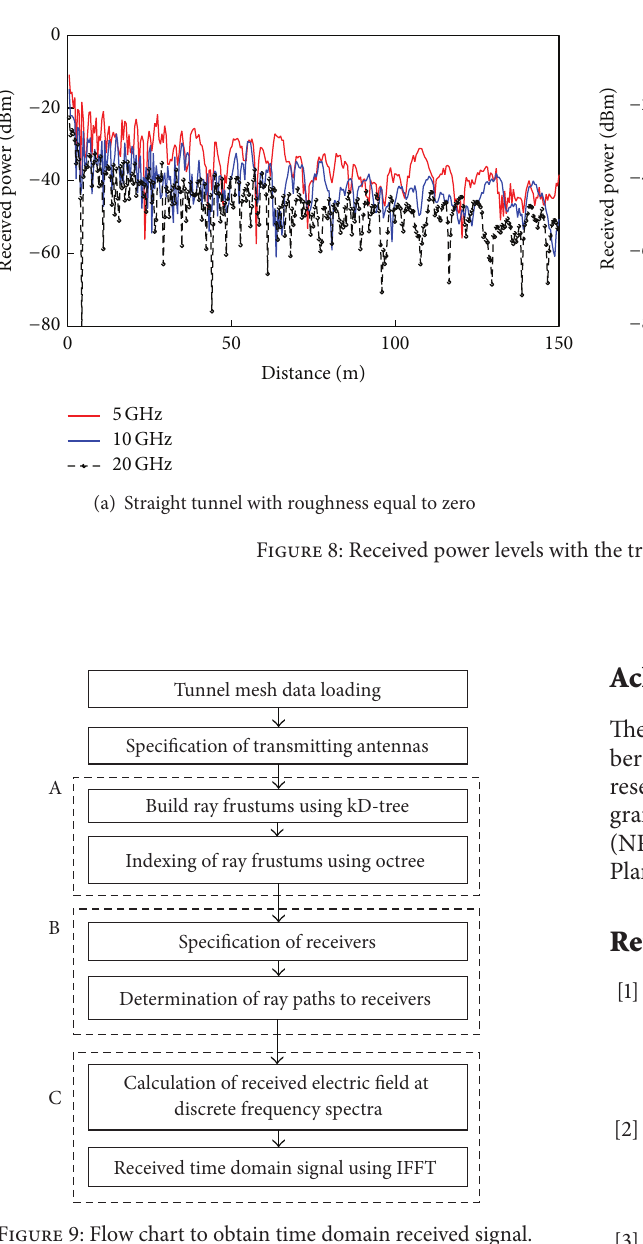
Figure 9: Flow chart to obtain time domain received